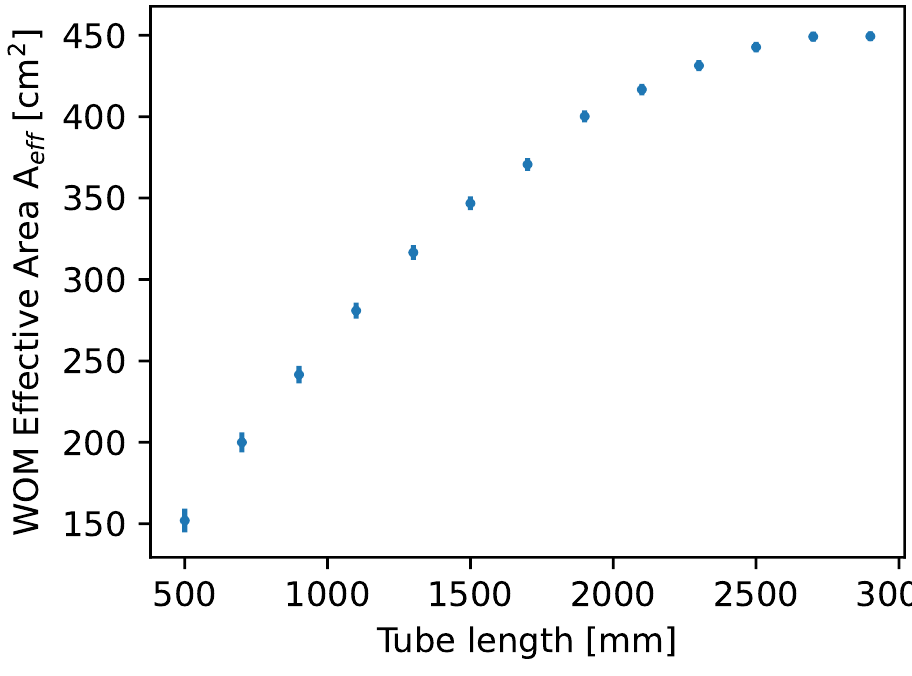
Figure 15. Scale of the effective area at low wavelengths in ice in dependence on the WOM tube length obtained by the MC simulation. Prototype specifications were used for all other properties of the